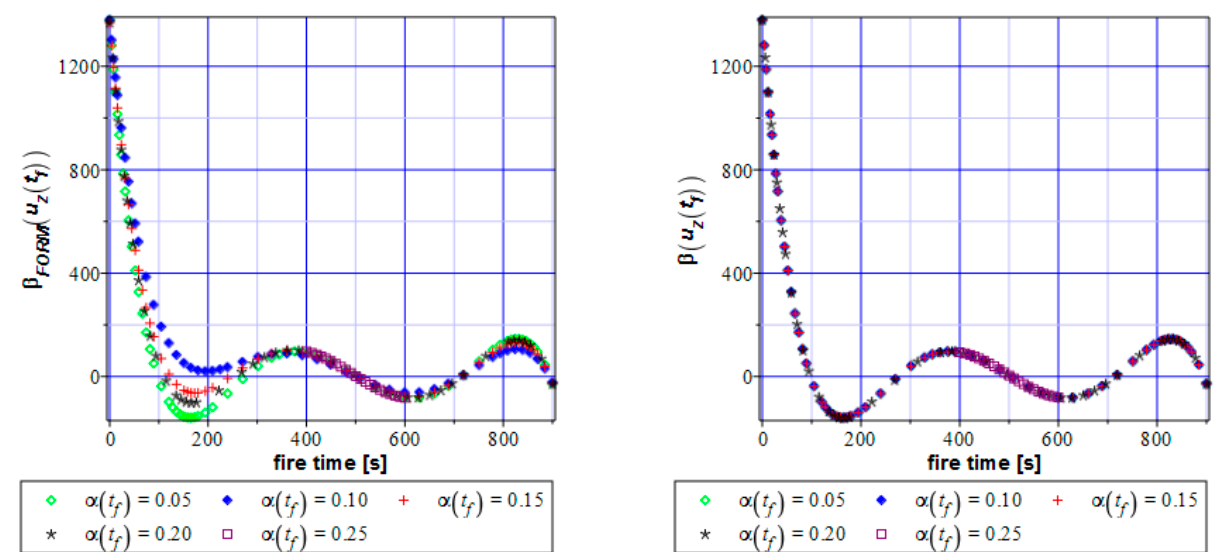
the FORM theory (left) and the relative entropy approach (right).